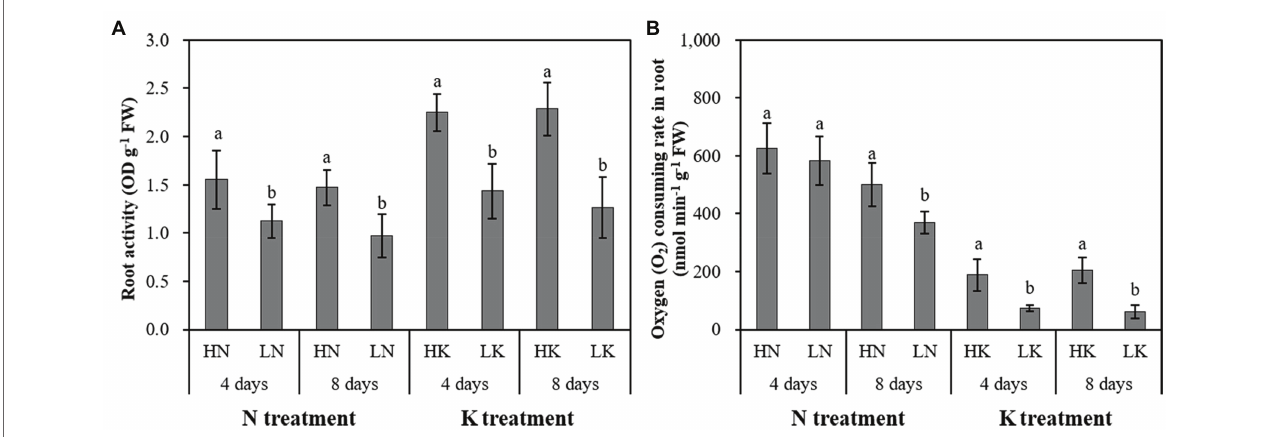
FIGURE 4 | The effect of N deficiency and K deficiency on the root activity (A) and oxygen (O 2 ) consuming rate in the root (B) of peanut seedlings, respectively. The data are the means ± SDs ( n = 5). The different letters on the bars indicate significant differences between the different N (or K) treatments and the control treatment on the same day according to the LSD test ( p = 0.05). N, nitrogen; K, potassium; and LSD, least significant difference.